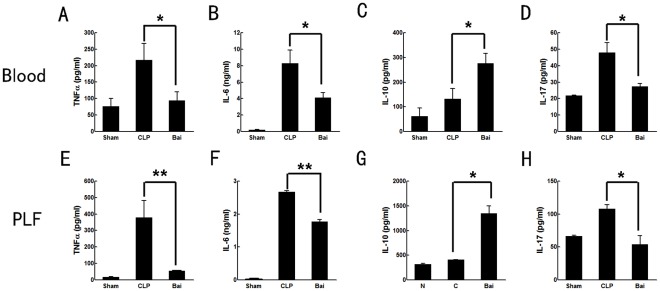
Cytokines expression of septic mice after baicalin injection.Baicalin reduced excretion of proinflammatory cytokines while increased anti-inflammatory cytokine. Samples were collected 24 h after CLP. Proinflammatory cytokines included TNF-alpha, IL-6 and IL-17 (A, B, D in blood and E, F, H in peritoneum). IL-10 represented the anti-inflammatory cytokine (C in blood and G in peritoneum). PLF, peritoneal lavage fluid; Bai, baicalin group; CLP, CLP group. Data analyses with one-way ANOVA and Newman-Keuls. * P<0.05, ** P<0.01.